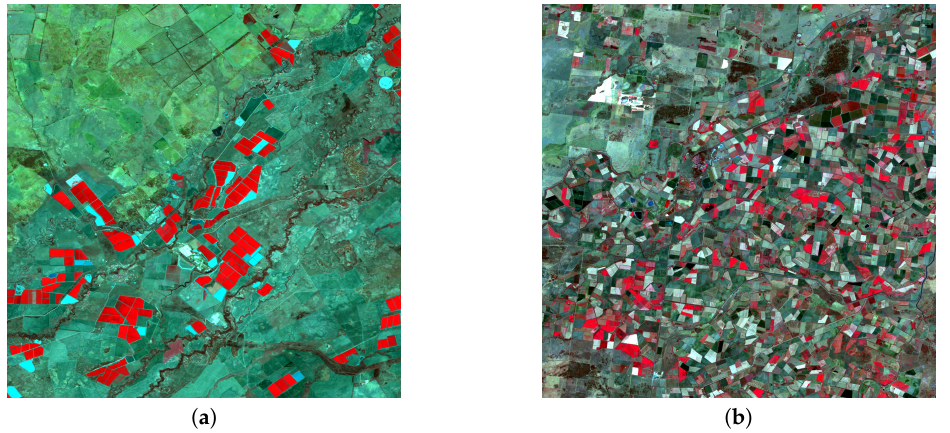
Figure 1. Real Landsat images of ( a ) LGC dataset and ( b ) CIA